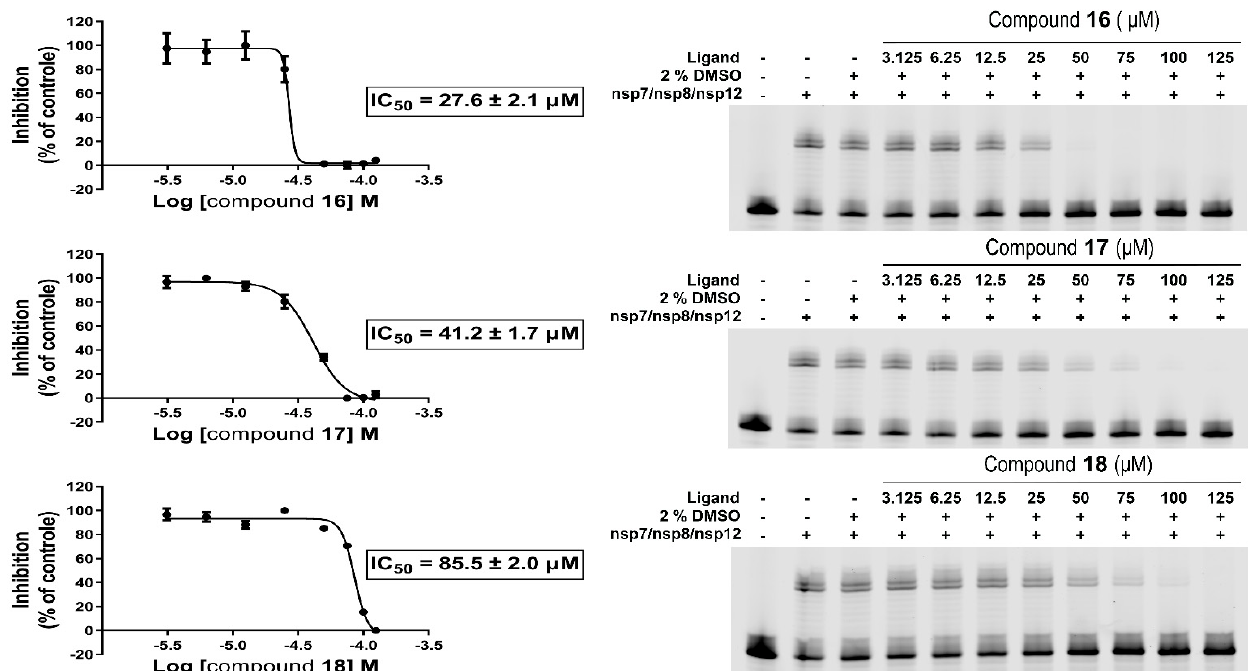
Figure 1. Inhibitions of SARS-CoV-2 RdRp by compounds 16 , 17 , and 18 . ( left ) IC 50 values were established for each tested compound using a radioactive primer extension assay. Error bars represent the standard error of the mean ( n = 3). ( right ) A fluorescence-based primer extension assay. Formation of the 40-nt product decreases with increasing concentration of the compound.